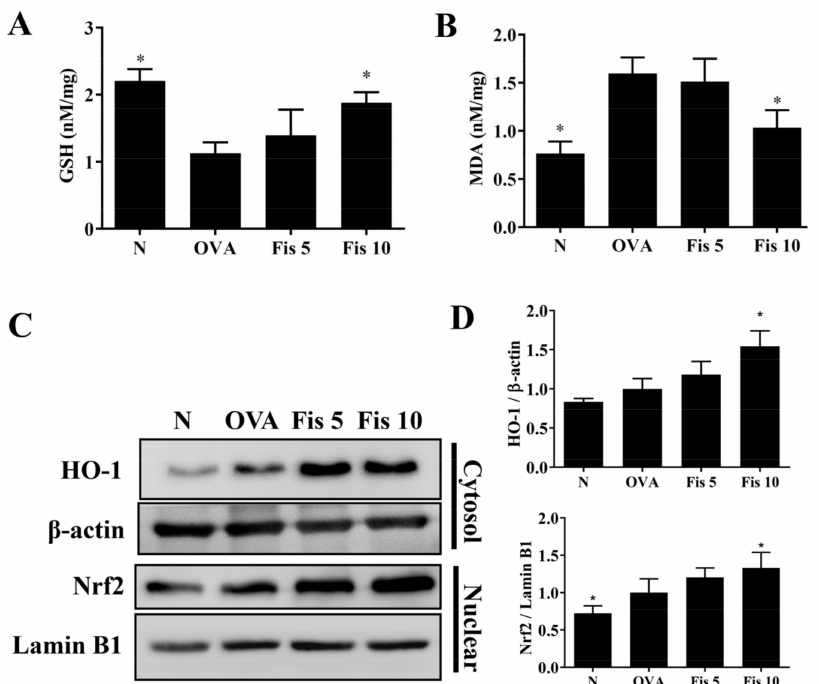
Figure 11. Effects of fisetin on oxidative stress factors in lung tissue. ( A ) GSH activity and ( B ) MDA activity measured in lung tissue. ( C ) Western blot of HO-1 and Nrf2 expression. ( D ) The fold expression of Nrf2 and HO-1 relative to the expression of lamin B1 and β -actin, respectively. The data are presented as mean ± SEM of three independent experiments, n = 3–6. * p < 0.05, compared to the OVA control group. N: Normal group; OVA: mice sensitized with OVA. OVA-sensitized